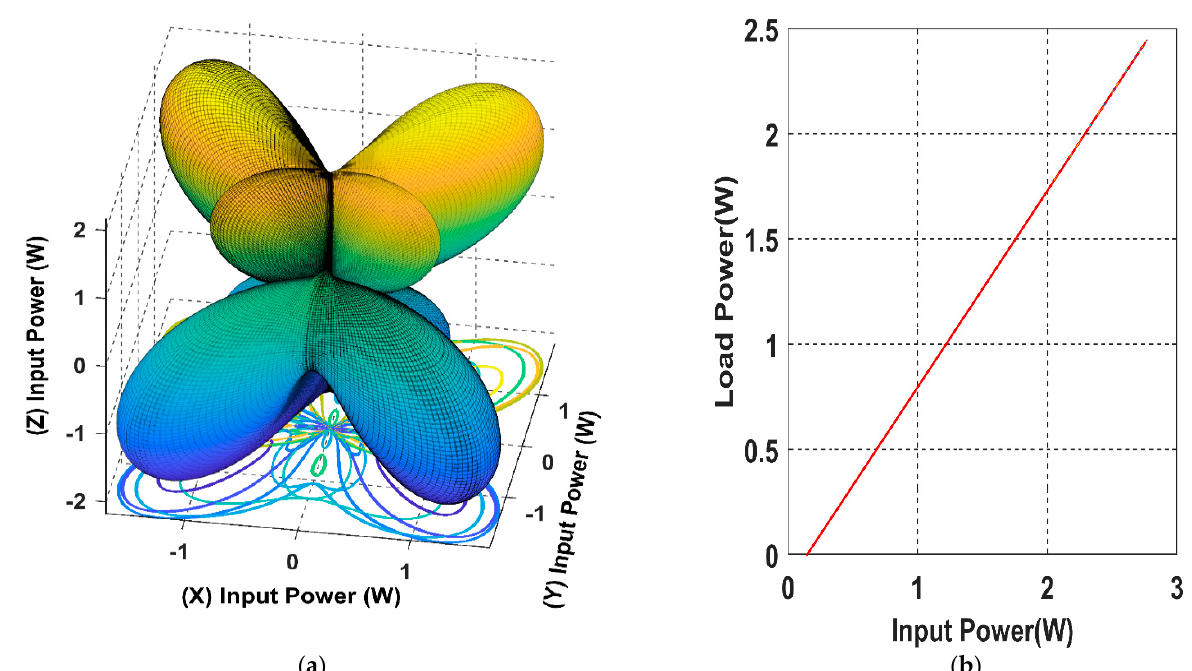
Figure 20. ( a ) The spherical plot of the calculated maximised input power when the receiver is moving according to the 8-shaped trajectory Γ . ( b ) The relationship between the input power and the load power for the 3D WPT system.